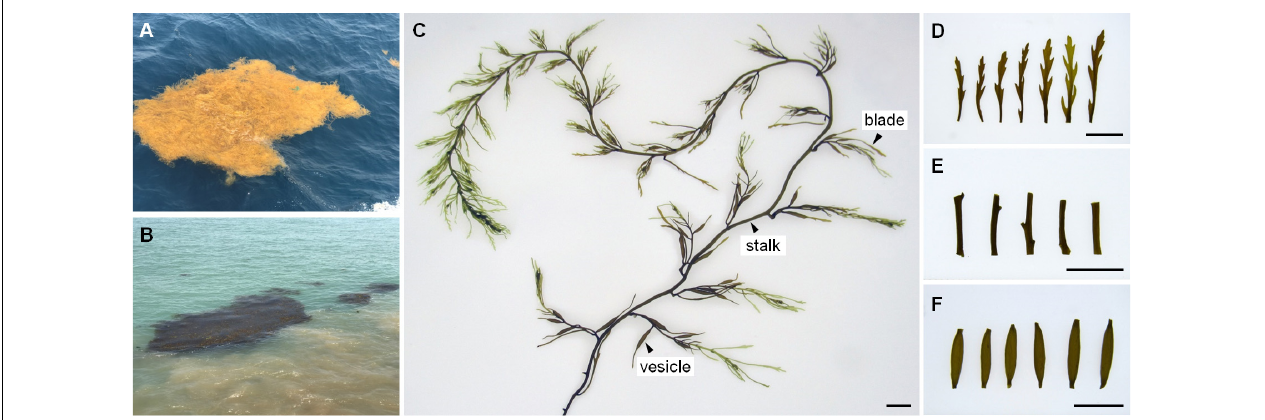
FIGURE 2 | The status in field, morphology and tissues of drifting Sargassum . (A) In light yellow from offshore site. (B) In dark brown from nearshore site. (C) Thallus. (D) Blades. (E) Stalks. (F) Vesicles. Scale bars = 1 cm.